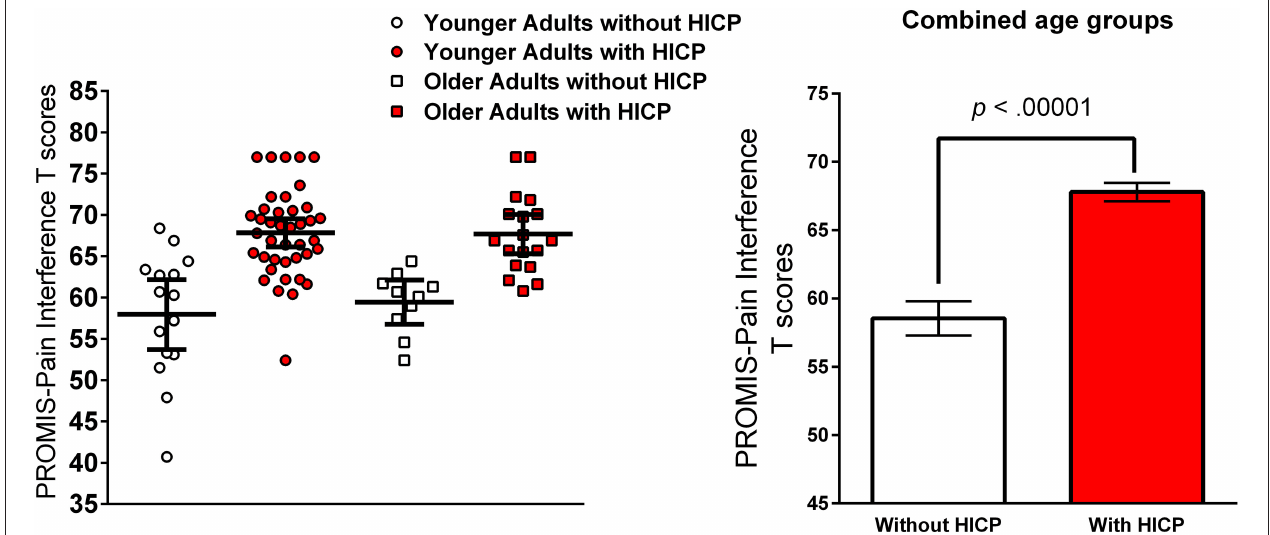
FIGURE 1 | PROMIS-PI T scores younger and older adults with and without HICP (left) and error bars are 95% Confidence Interval. Comparison of PROMIS-PI T scores between the group with and without HICP (right) and error bars are